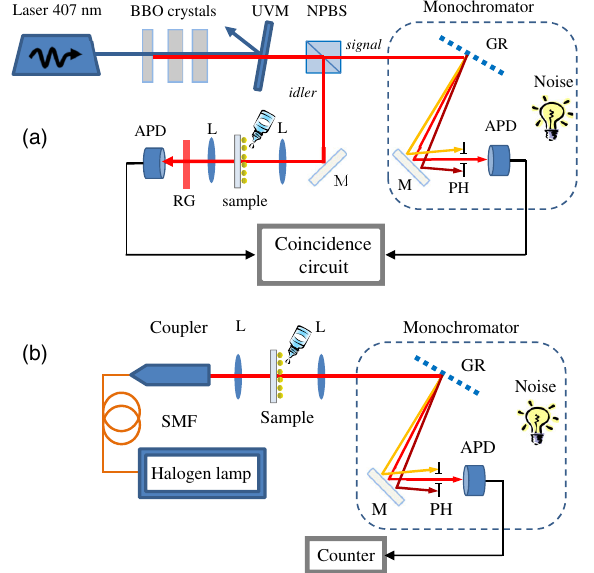
FIG. 1. (a) Quantum spectroscopy setup. Diode laser at 407 nm is used as a pump for a set of three BBO crystals cut for type-I SPDC; the UV mirror (UVM) reflects the pump beam and transmits the SPDC signal; a nonpolarizing beam splitter (NPBS) splits the SPDC signal into two arms; in one arm, there is a monochromator, which consists of a mirror (M), a diffraction grating (GR), a pinhole, and an APD. In another arm, there is a sample, which represents an array of gold nanoparticles as- sembled into a cell. The SPDC signal is focused onto the sample by achromatic lenses (L), filtered by a red glass filter (RG), and detected by the APD. Counts of the two APDs are sent to a coincidence circuit; the source of the noise is provided by the external APD, illuminated by the lamp (not shown), whose signal is mixed electronically with the signal of the APD in the signal channel. (b) Transmission spectroscopy setup. A halogen lamp is usedasasourceofthebroadbandlight; thelightafterasinglemode fiber (SMF) is collimated by a coupler, focused by lenses onto the sample, filtered by the monochromator, and detected by the